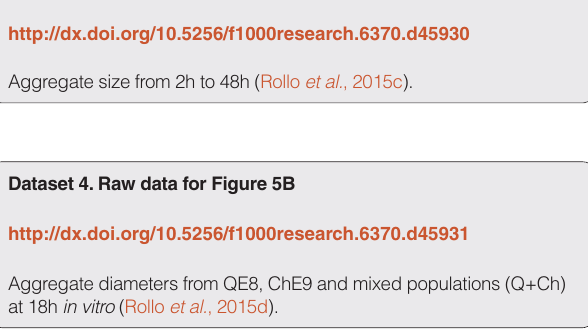
Dataset 4. Raw data for Figure